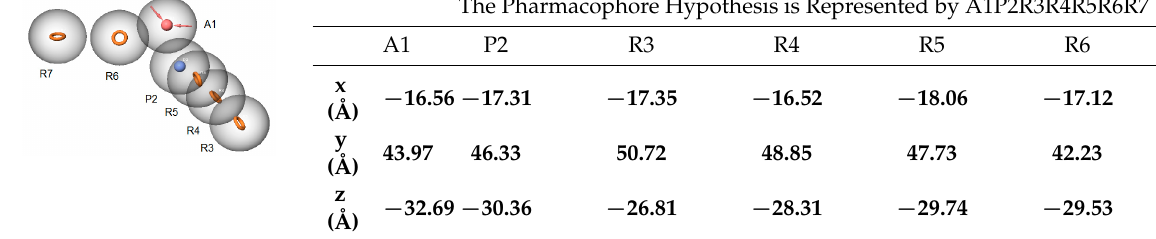
Figure 3. Virtual screening cluster of compounds for BQS salts in interaction with ATP synthase is represented as a scatter plot: x - and y -axis represent coordinates of each compound characterized by its properties: relative energy, phase vector score, phase volume score (see supplemental files). The single pharmacophore hypothesis of salts in complex with TOPO II is repre- sented in Table 5; the pharmacophore hypothesis is generated using cartesian coordinates, and the type of 3j atoms is represented. Table 5. Pharmacophore hypothesis for salt in complex with TOPO II. Pink spheres represent acceptor atoms, blue spheres represent positive ionic atoms, and orange rings represent aromatic centers. CC cartesian coordinate (Å).